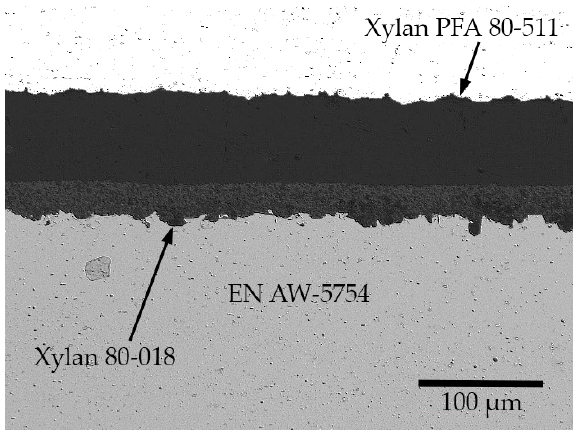
Figure 2. EN AW 5754 substrate with PFA coating (mounting with an aluminum backing plate to preserve the edges).